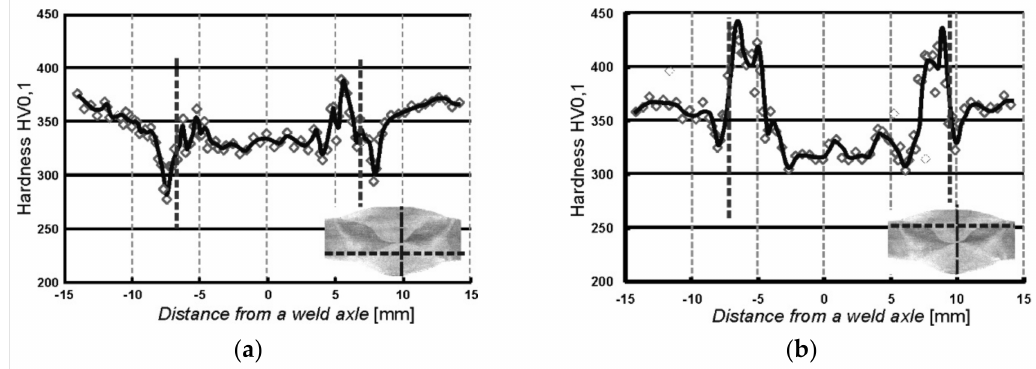
Figure 6. Distribution of micro-hardness measured in the WJ-S joint on: ( a ) the side of first welding run; ( b ) the side of second welding run.